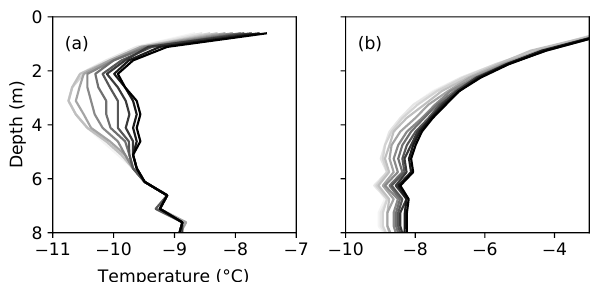
Figure 4. Heating events from temperature string T-16. Profiles are plotted as in Fig. 3c, d, and e. The time steps between profiles are 2h (a) and 4h (b) .